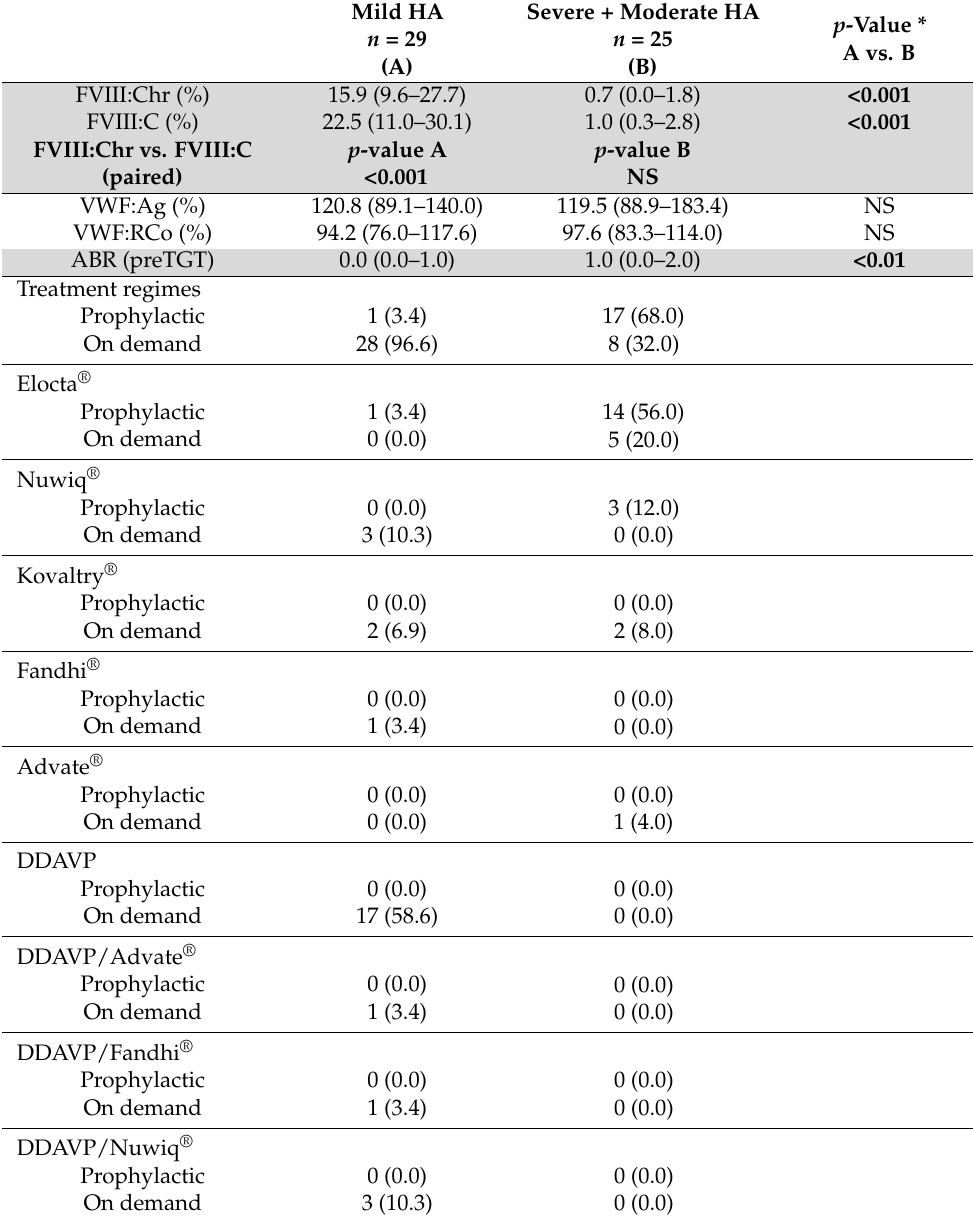
Table 1. Clinical characterization of the HA cohort of study at